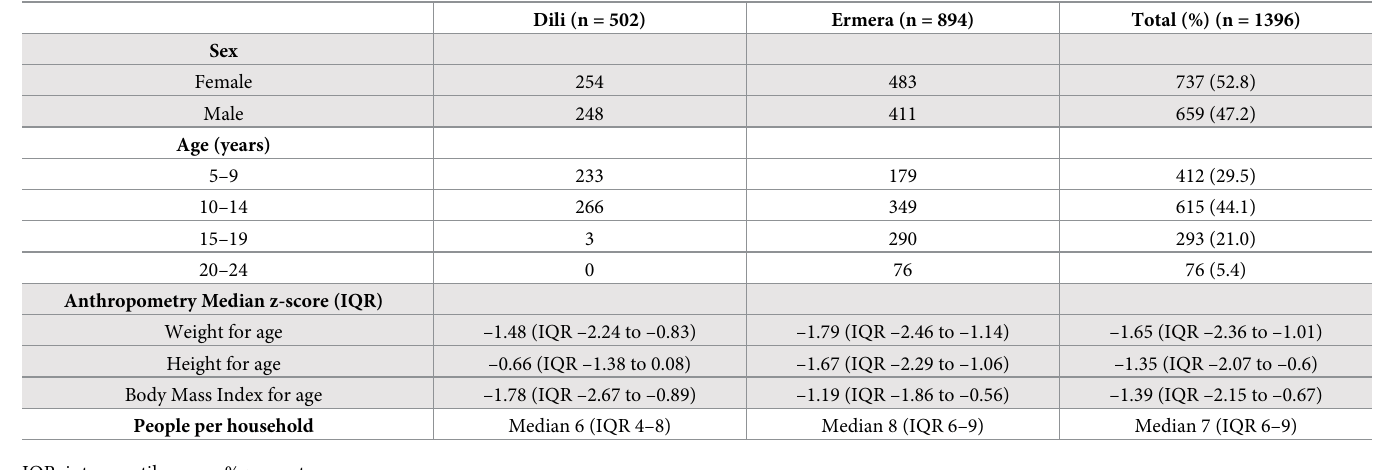
Table 1. Demographic